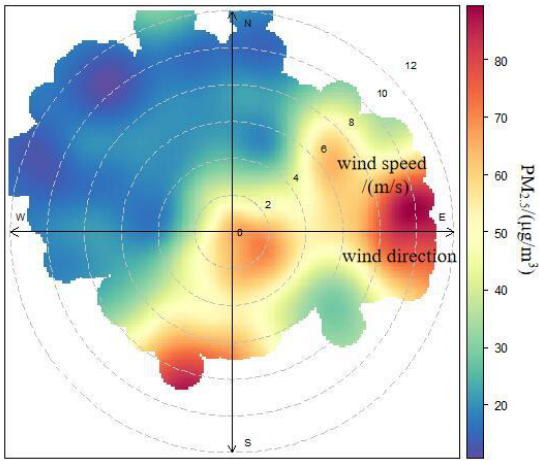
Figure 5. Relationship between wind direction, wind speed, and PM 2.5 .